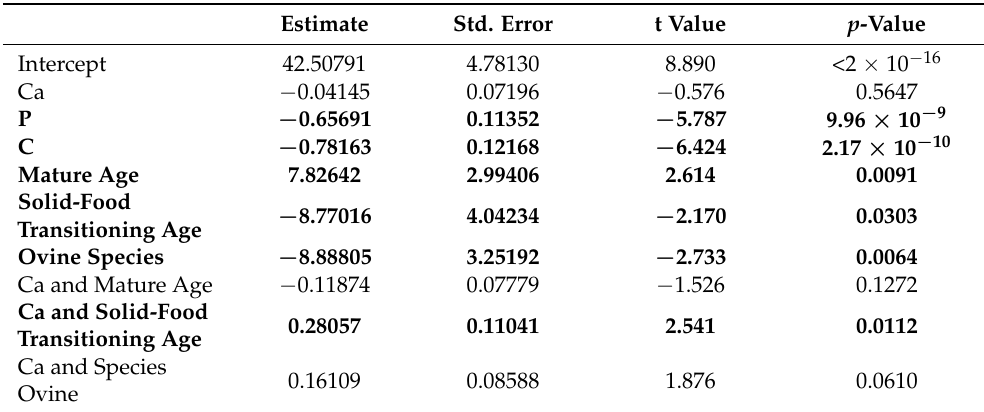
Table 5. Multiple regression analysis in which all variables were regressed against the elastic modulus (R 2 = 0.235). The bold font indicates statistically significant variables. Estimate Std. Error t